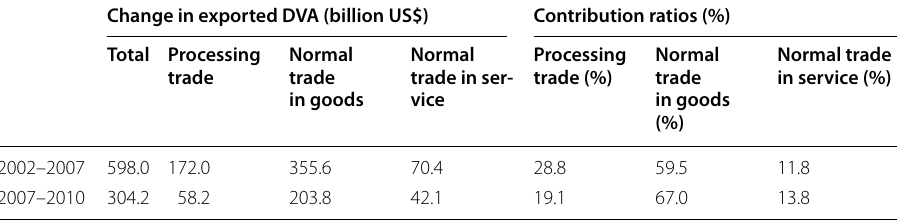
Table 3 Change of DVA in China exports in period 2002–2007, 2007–2010 Change in exported DVA (billion US$) Contribution ratios